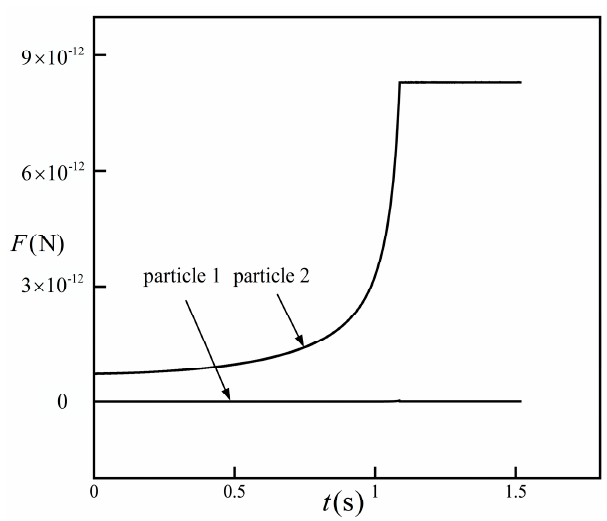
Figure 6. The DEP interactive forces of particle 1 and particle 2 with time. The force of particle 1 is almost zero, the force of particle 2 increases rapidly as particle 2 get closer to particle 1, and finally reaches a constant value when the particle group is formed.